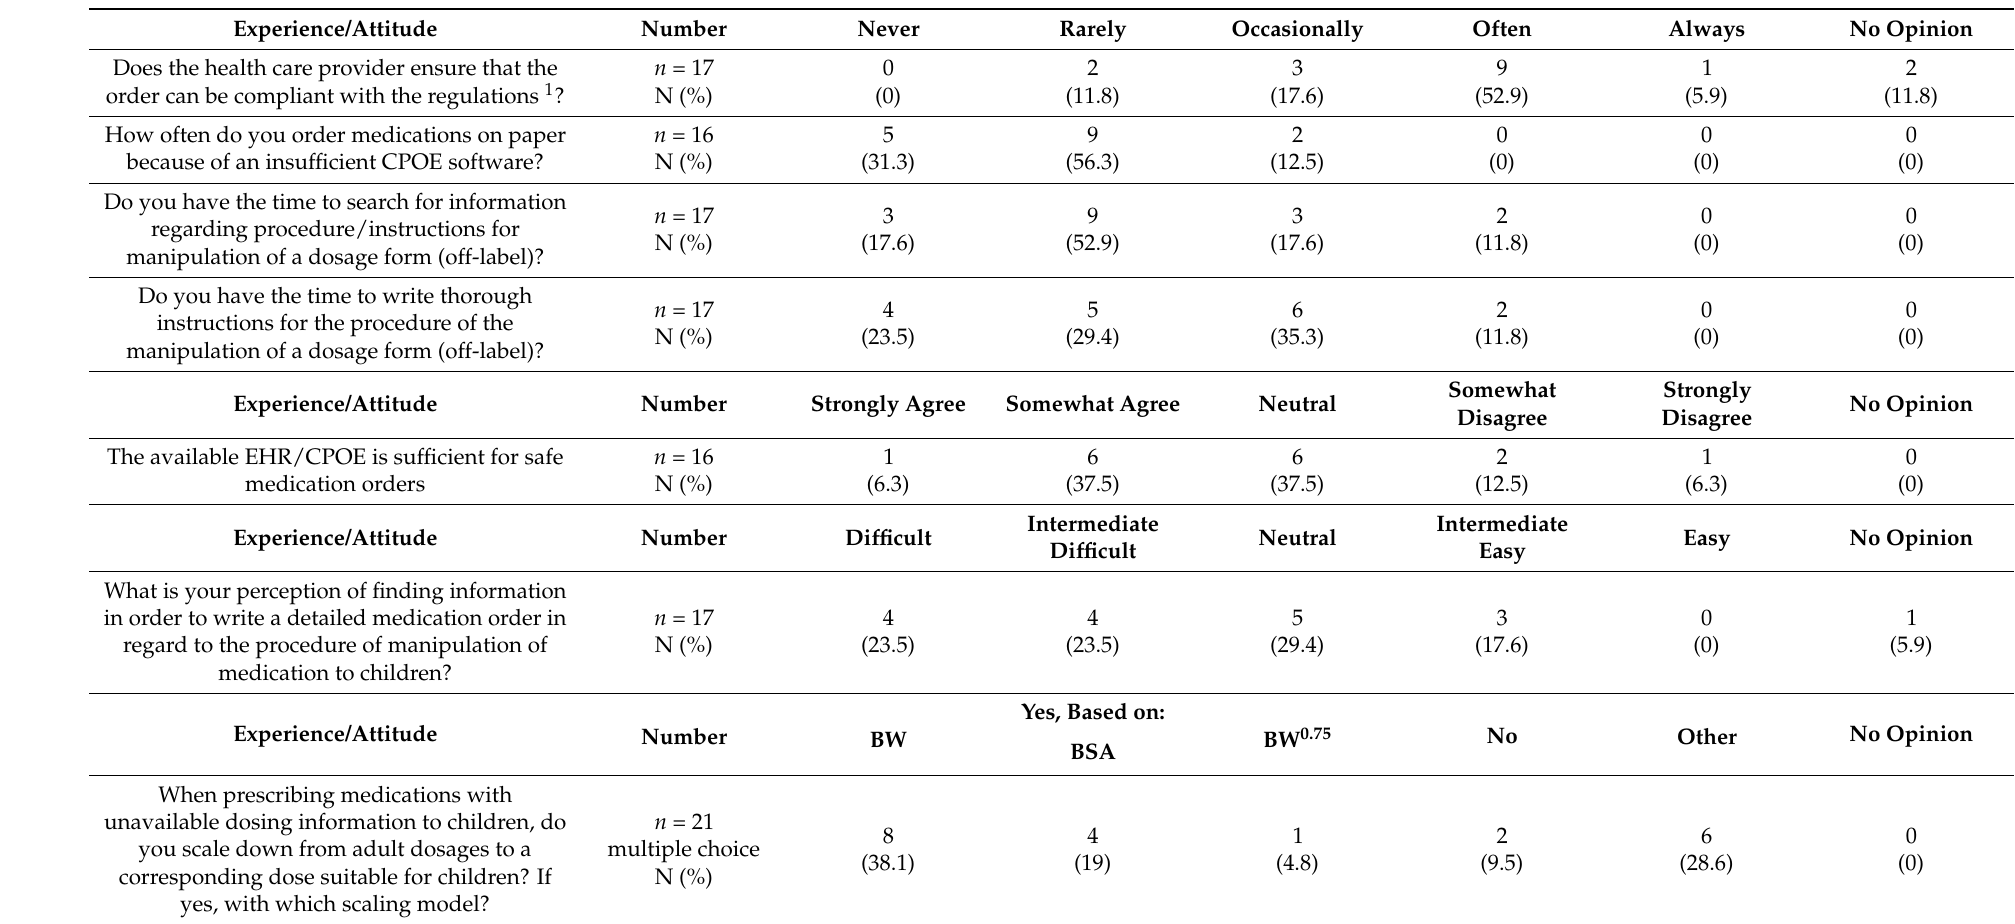
Table 4. Responding consultant paediatric oncology and neurology paediatricians’ experiences and